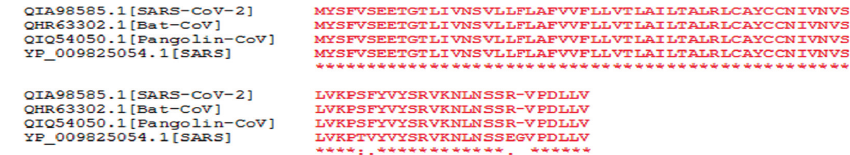
Figure 1: Alignment of the amino acid sequences of the E protein of four coronaviruses along with their accession